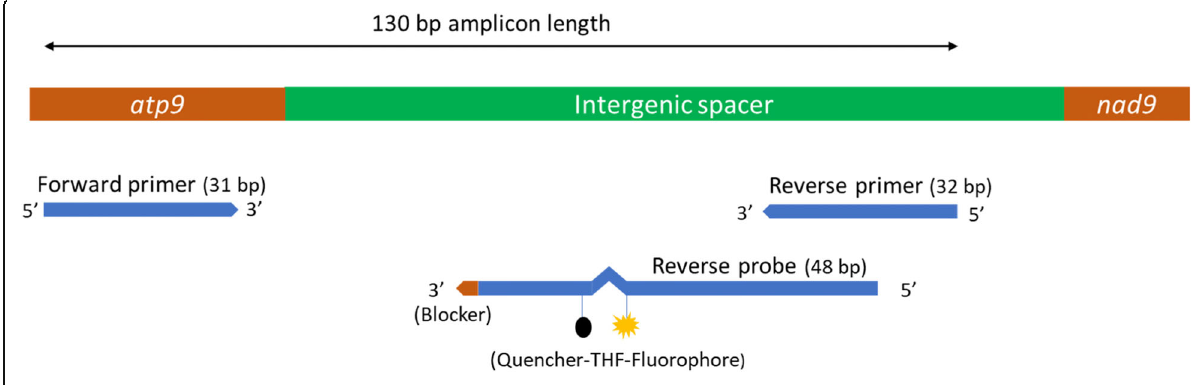
Maceration buffer